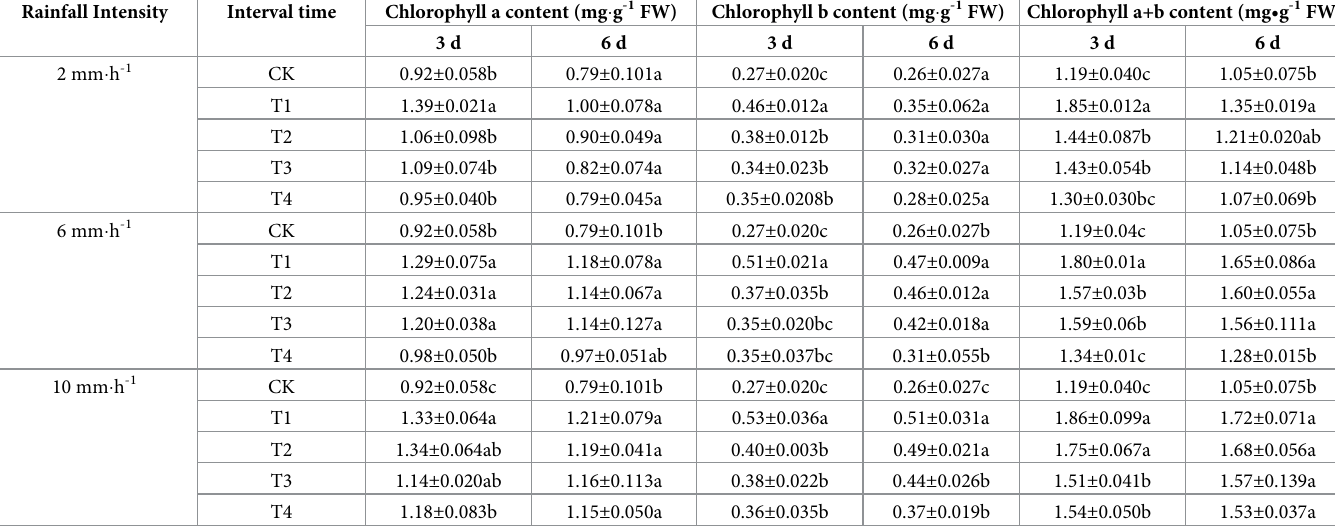
Data are shown as mean ± SE with the different lowercase letters in the same column represent significant differences (P < 0.05).